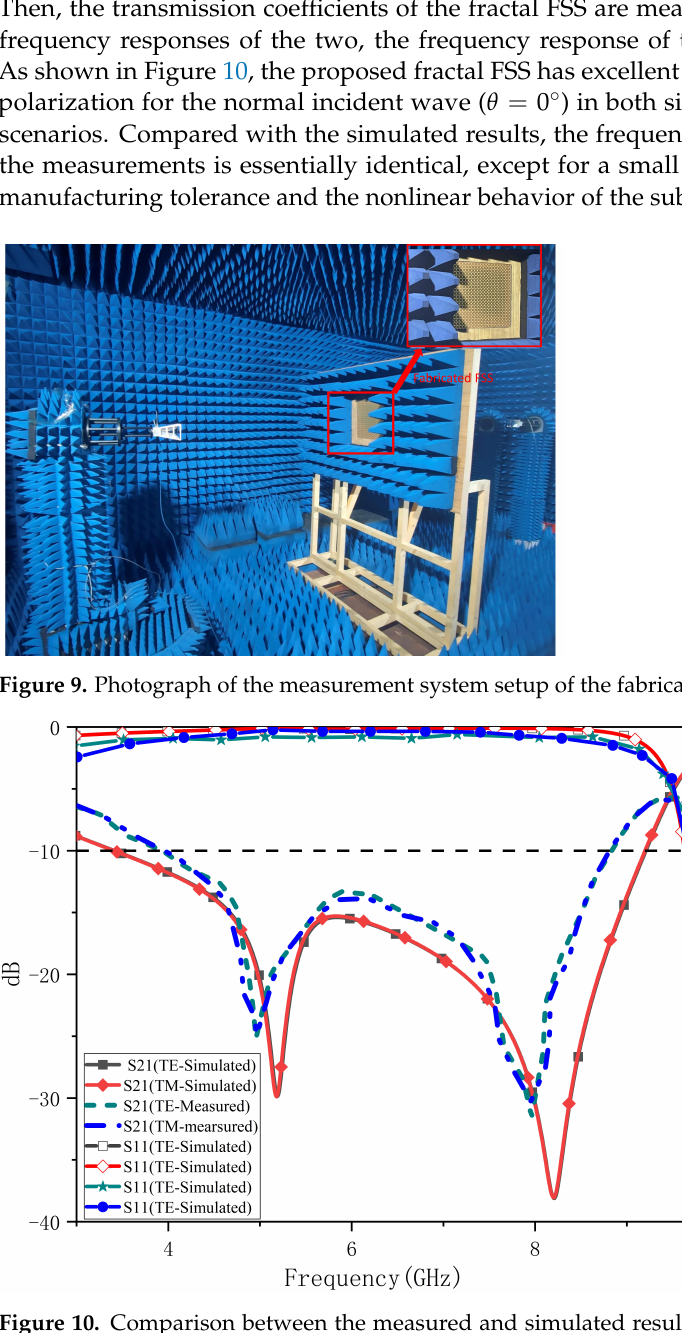
Figure 10. Comparison between the measured and simulated results of the proposed fractal FSS under TE and TM polarization for the normal